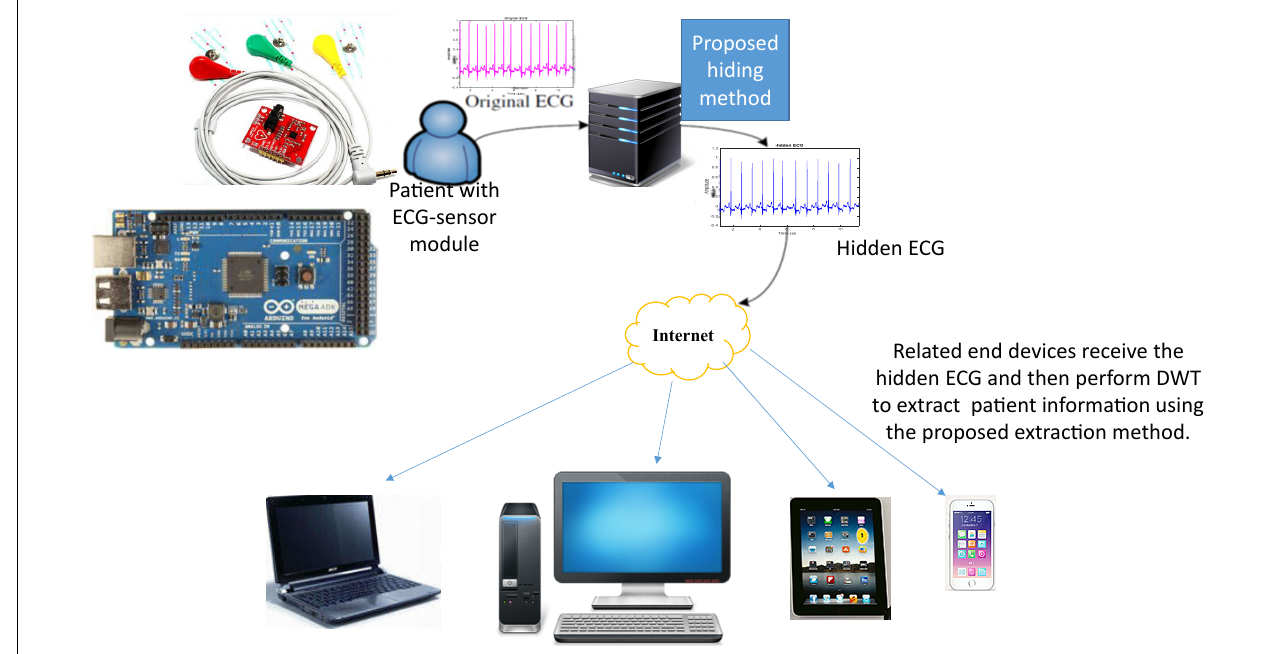
FIGURE 3 | Proposed intelligent multiple-coefficient quantization hiding and communication system for patients’ confidential